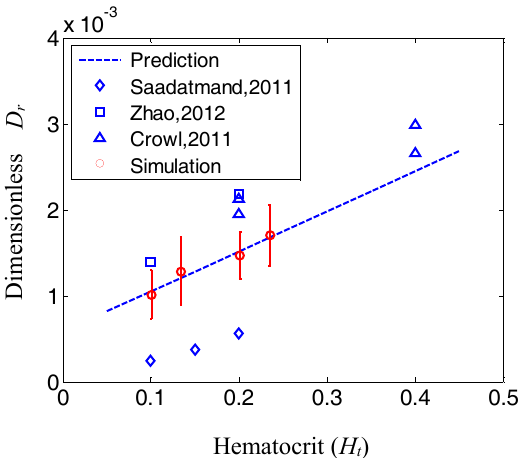
Figure 8. Comparison of the particle dispersion rate predicted from Equation (18) with the data reported in the literature. The dashed line is the prediction from Equation (18).